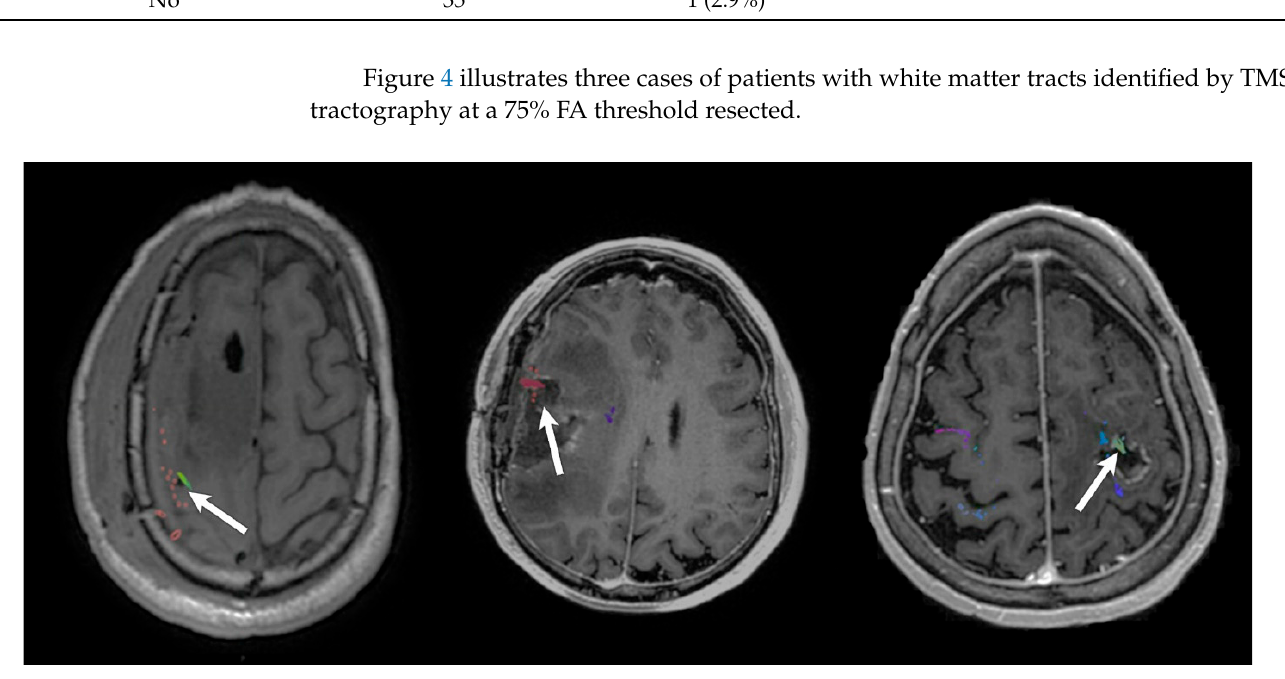
Figure 4. Three patients with permanent deficits showing the resection cavity overlapping with white matter tracts identified by TMS-seeded DTI tractography at 75% FA threshold. Arrow points to the overlap indicating resection of tracts.